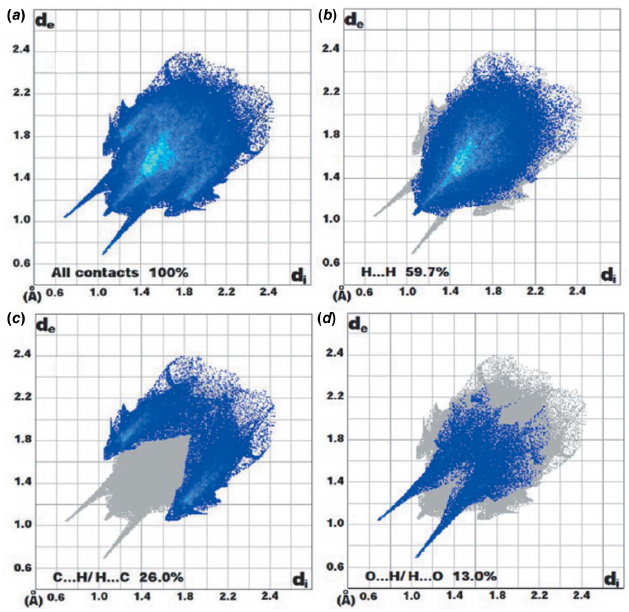
Figure 3 Two views of the Hirshfeld surface mapped over d norm .